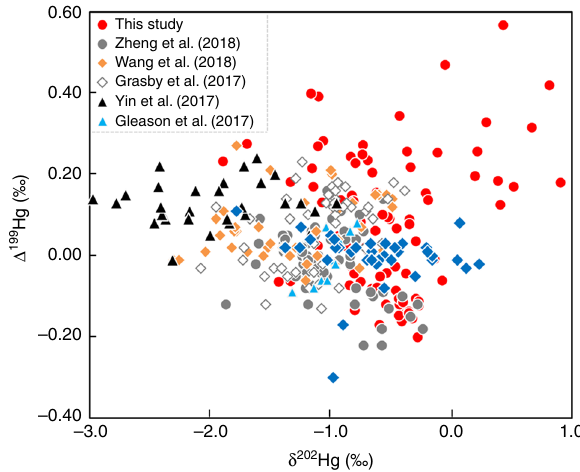
Fig. 4 Cross plots of mercury isotope data from marine sediments. These include δ 202 Hg versus Δ 199 Hg from late Late Archean sediments (our data) compared with Late Mesoproterozoic shales from Africa 23 , Early Cambrian shales from China 17 , end-Permian sediments from China 16,41 , end-Triassic shelf sediments from North America 58 , and Eocene shales from the Arctic Basin 40